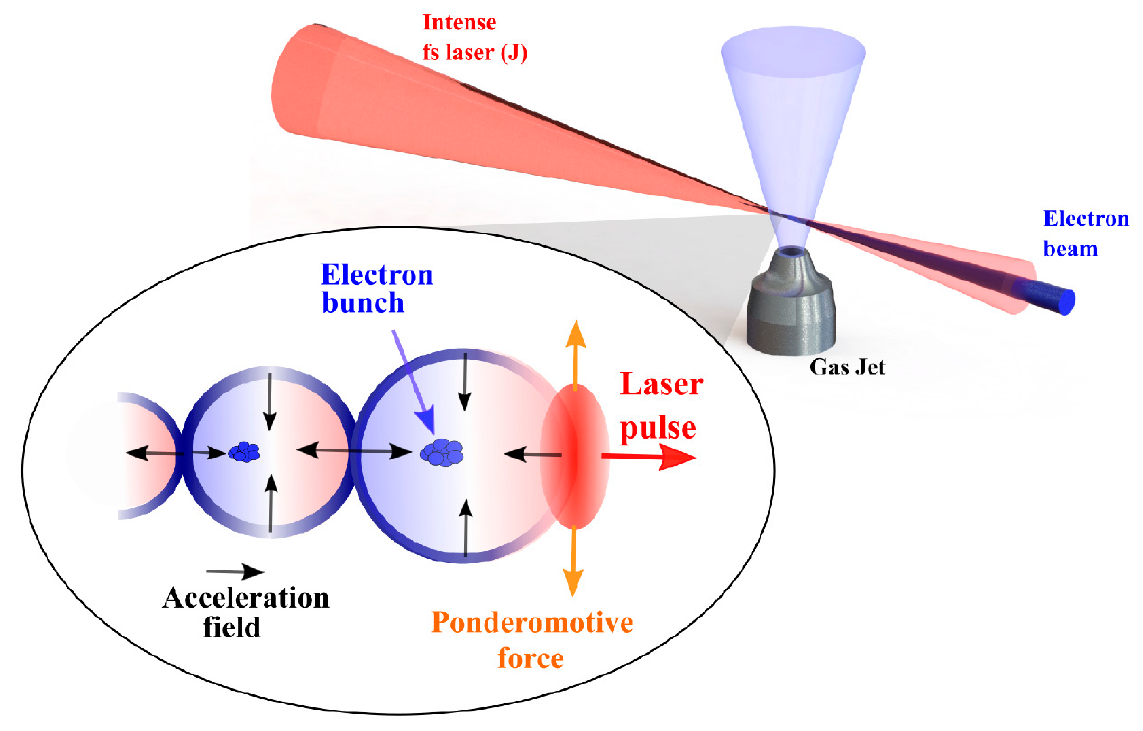
Figure 1. Schematic of LWFA process.